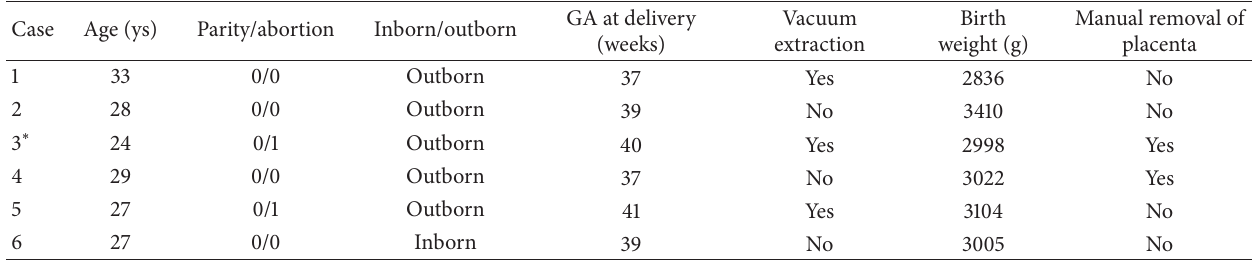
Table 1: Demographic data of women with uterine inversion. Results are expressed as the number of individuals. GA: gestational age. ∗ Geographical disadvantage for transfer (more than 40 minutes by ambulance